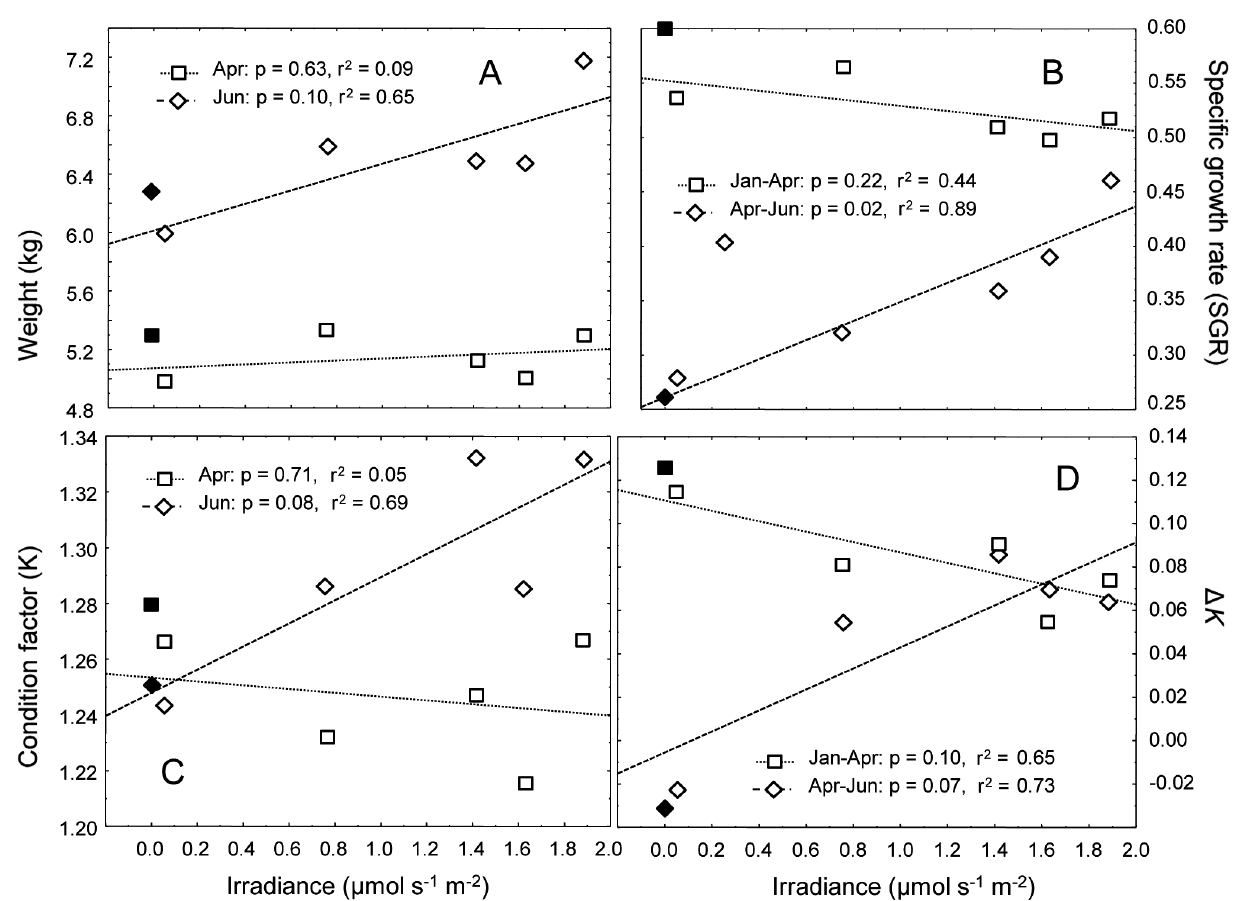
Fig. 6. Correlation between irradiance 3 m from the LED light sources (vertical line in Fig. 3) and (A) weight, (B) specific growth rate, (C) condition factor K and (D) change in condition factor ( Δ K ) of Atlantic salmon Salmo salar . The corresponding values of the natural light (NL) group (black symbols) are included for illustrational purposes, but were not included in the correlation analysis